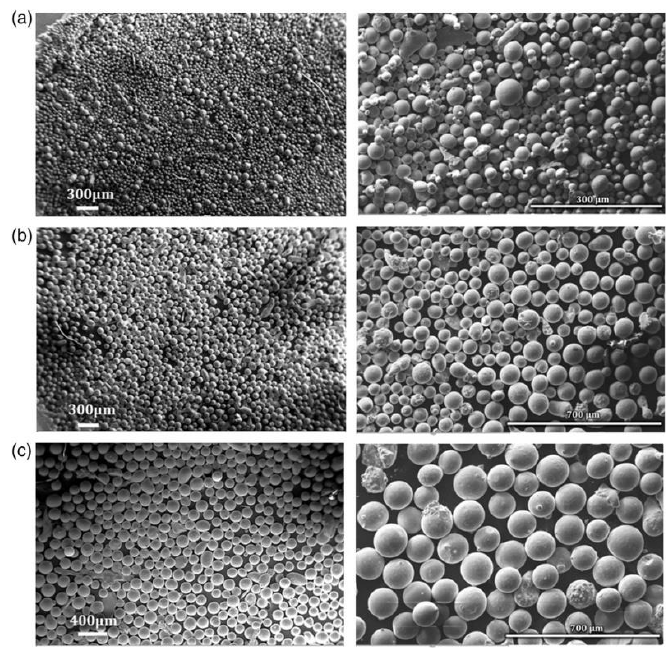
Figure 2. Scanning electron microscope (SEM) images of GA produced Ti4522XD powders with sizes: ( a ) d < 45 μm; ( b ) 45 μm < d < 100 μm; and ( c ) 100 μm < d < 150 μm , reproduced from [21], with